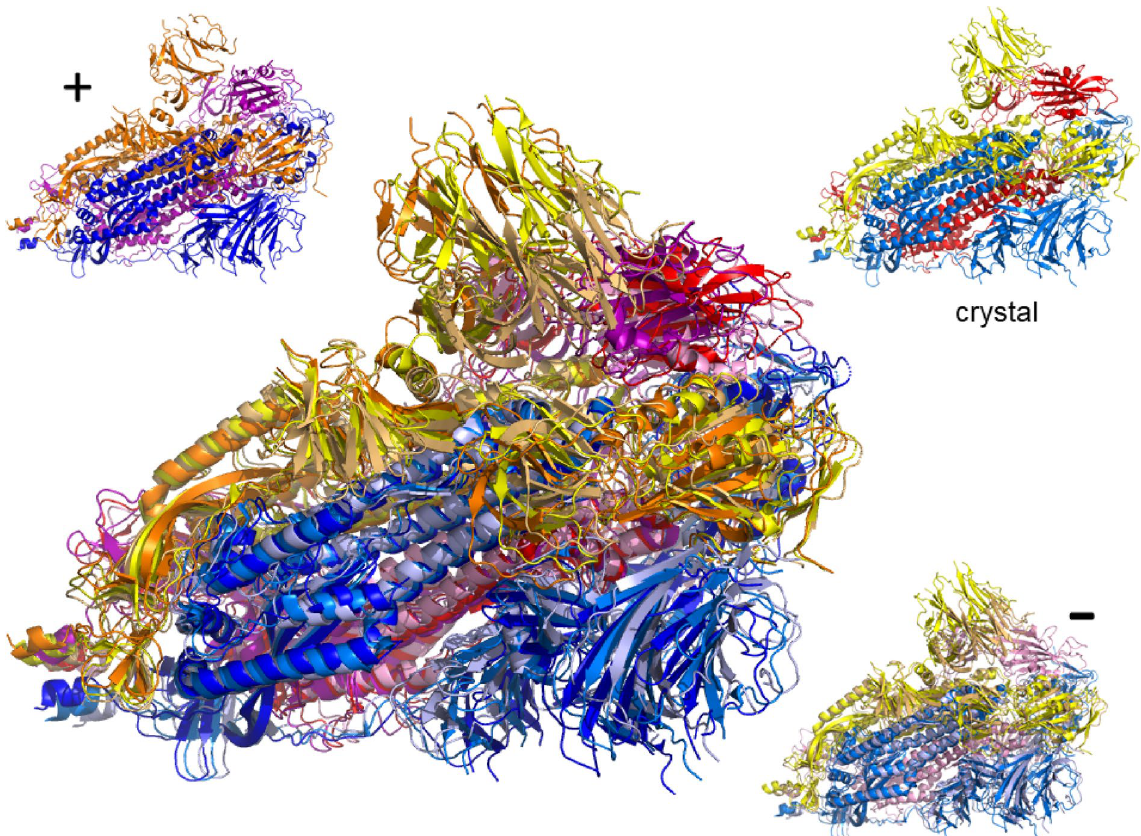
Figure 6. Side views of motion in the spike ecto domain in closed configuration (6vxx) 9 for m 7 motion at E cut = 2 kcal/mol for the whole trimer. The secondary protein structure is highlighted by the chosen “cartoon” representation. As in Fig. 5, colors yellow, blue and red denote chains A, B, and C, respectively, while color combinations light orange/orange, pink/purple and light blue/dark blue show the extreme structural positions for the movements along m 7 . The smaller protein structures show the initial (crystal) structure as well as the extremes ( + , –) along m 7 in the same colors as in the superimposed